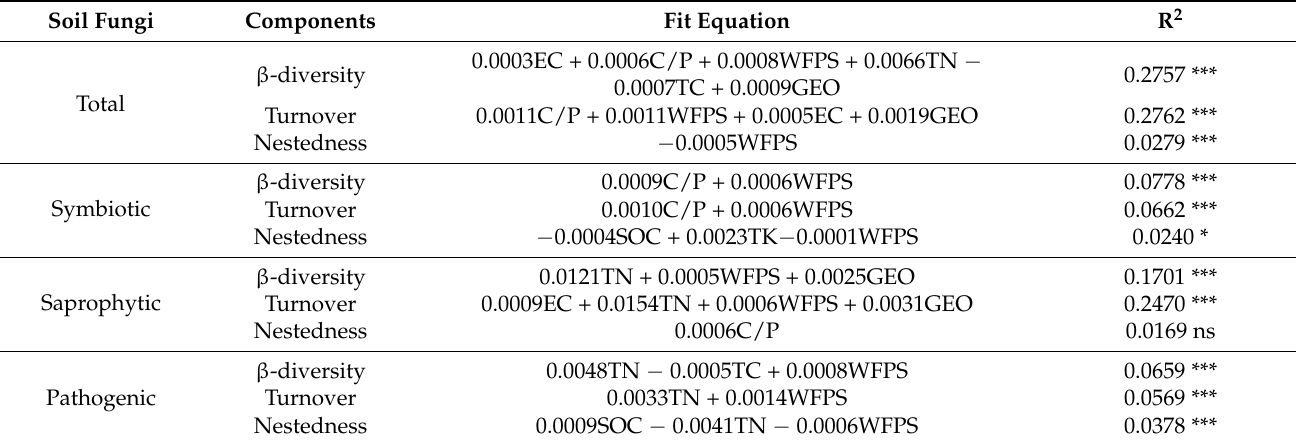
Table 4. Results of the MRM test for soil properties, geographic distance (GEO), and β